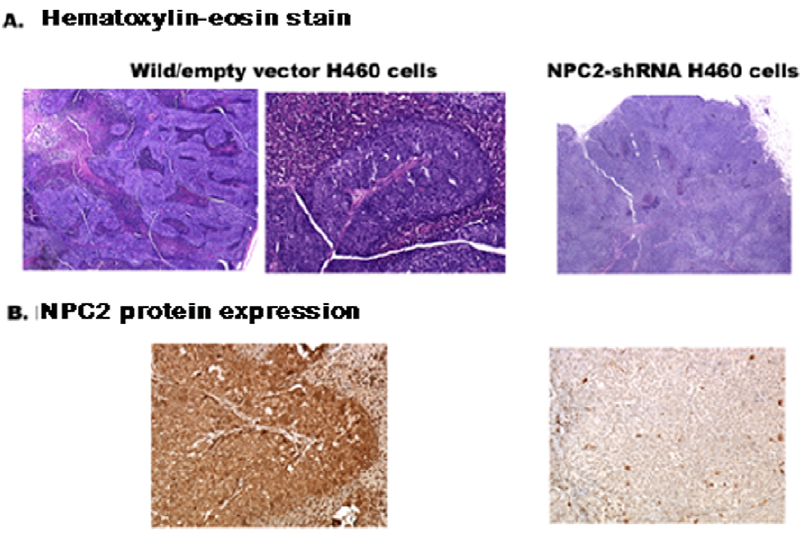
Figure 4. Papillae formation in xenografts of three types of H460 cells. A: Hematoxylin-eosin stain. B: Immunohistochemical stain for NPC2 protein. Distinct papillae formation was seen in wild and empty vector cells. No papilla was seen in NPC2-shRNA containing cells (A). NPC2 protein was localized in the epithelium of papillae (B).